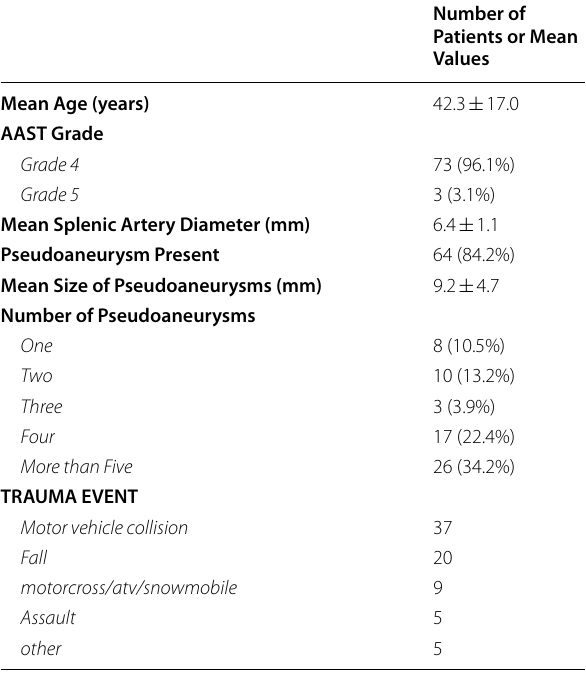
Table 2 Preprocedural details including CT findings